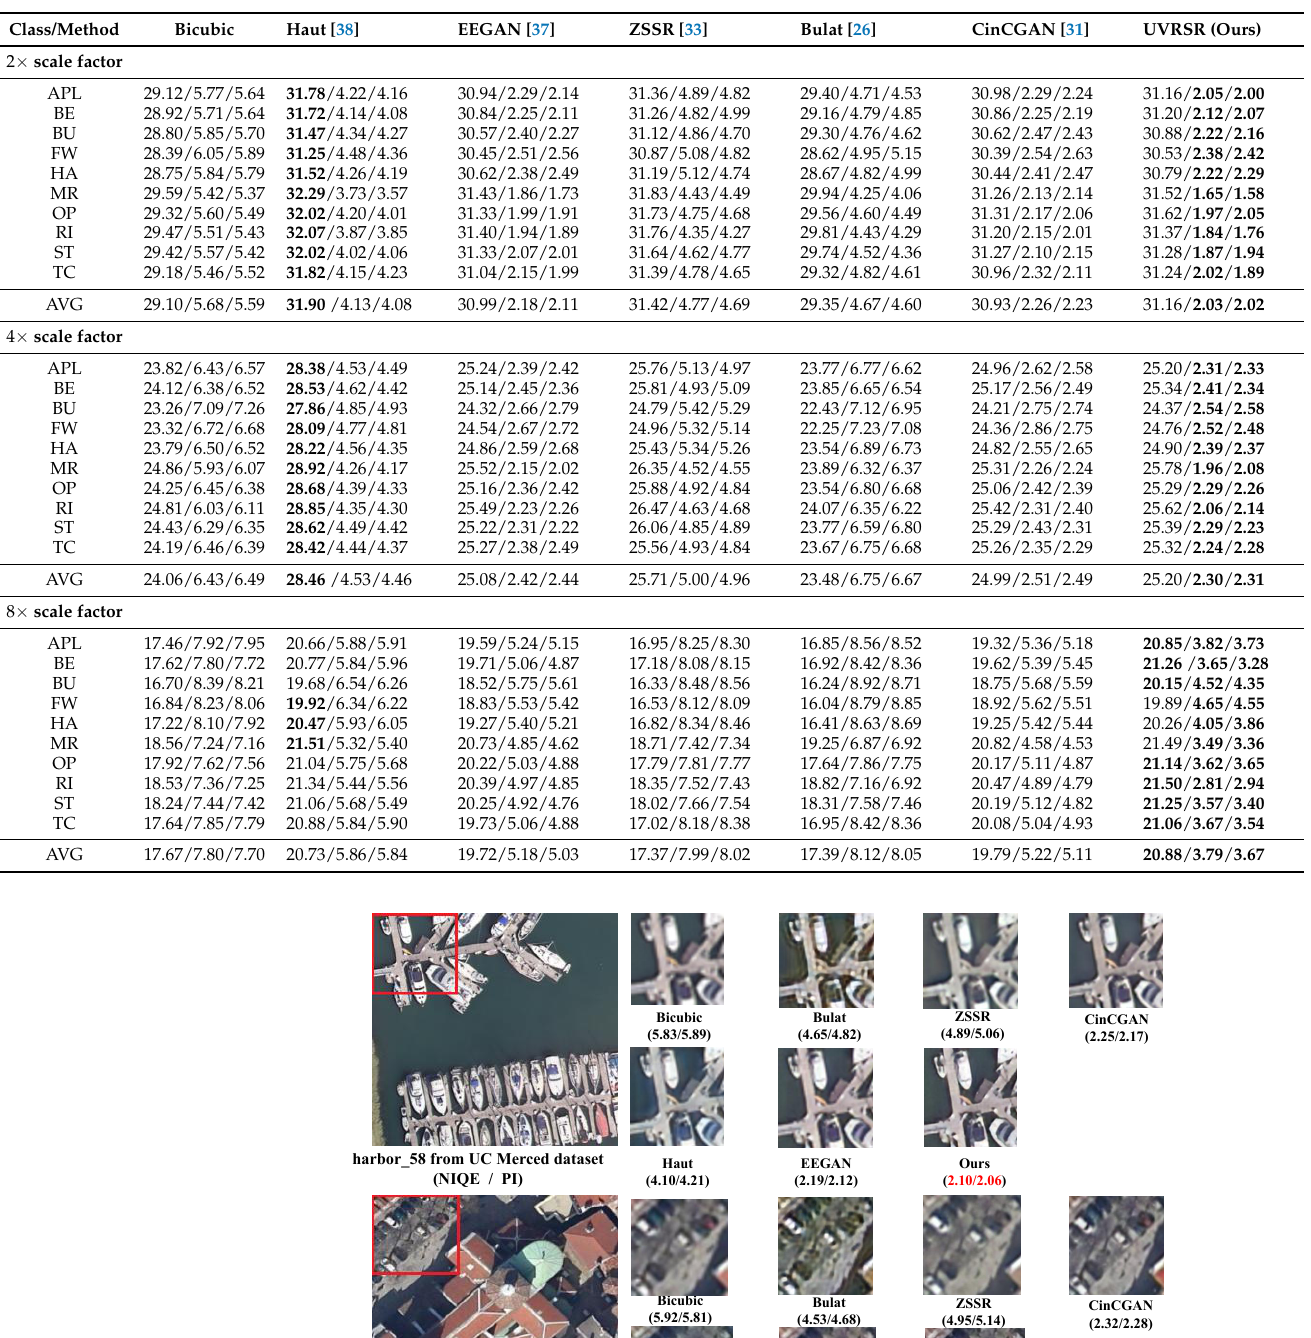
Table 1. Quantitative comparisons with state-of-the-art methods on the UC Merced dataset and